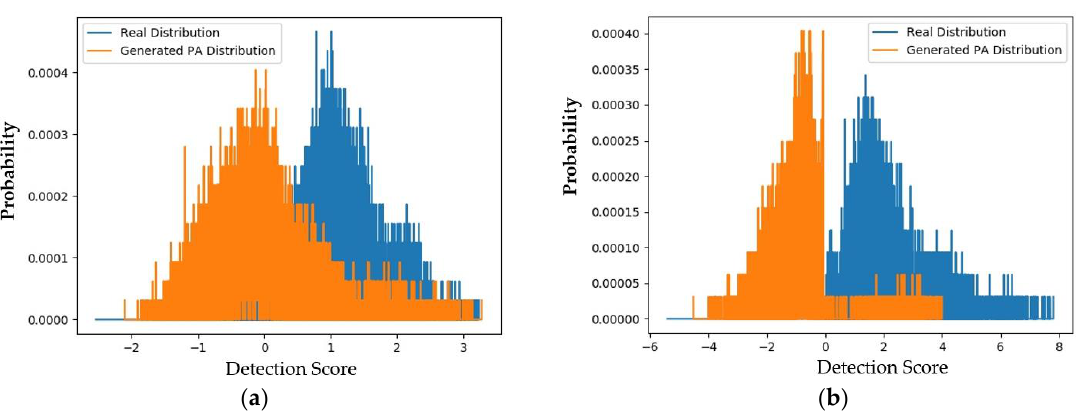
Figure 12 . Distribution of detection scores of captured real and generated PA images for the Replay-